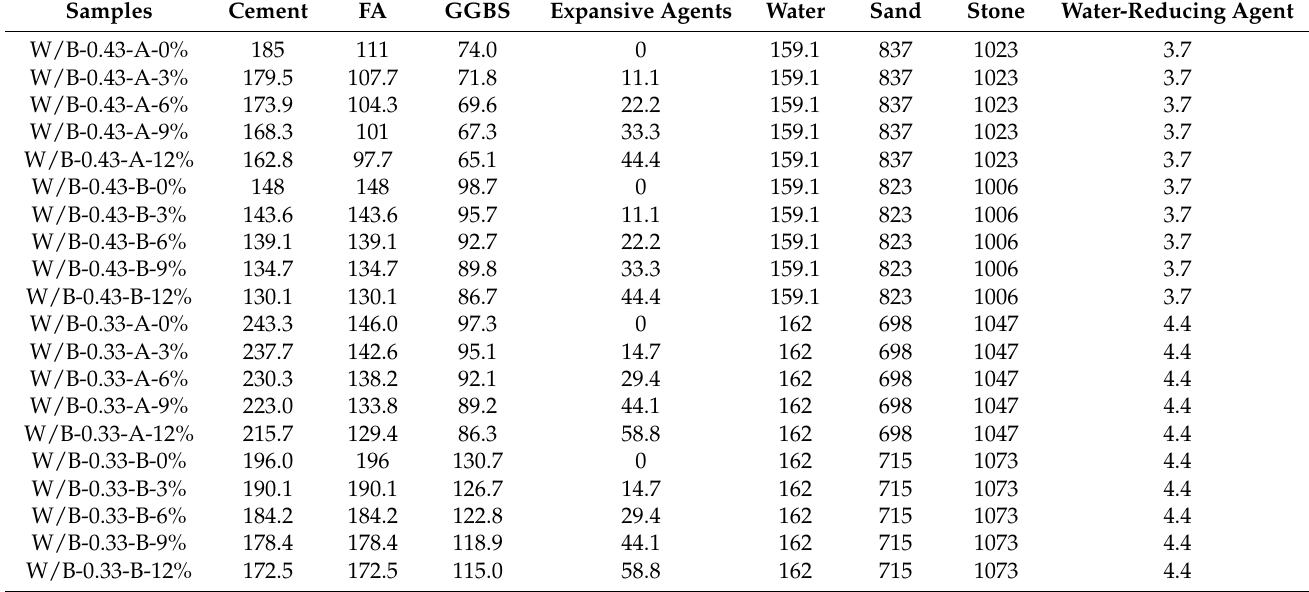
Table 2. The mix ratio of concrete with water–binder ratios of 0.33 and 0.43 (kg/m 3